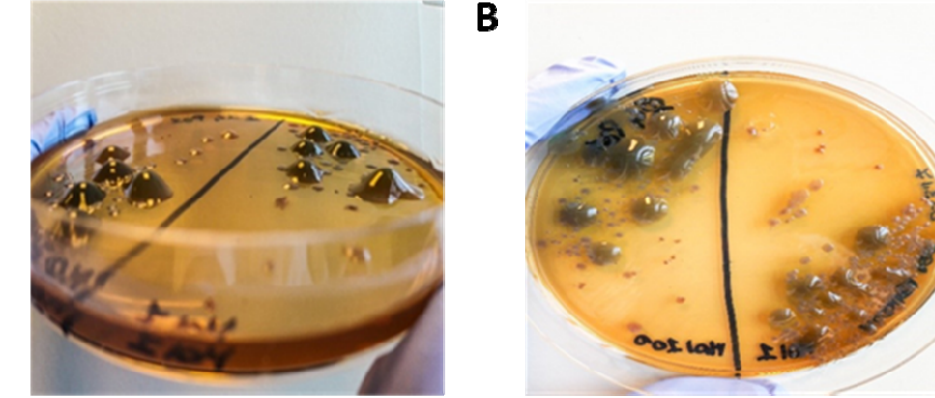
Figure 6. Mucoid Pseudomonas aeruginosa (PA) phenotypes observed in the biofilm supernatants exposed to phages. ( A , B ) Blob-like, raised mucoid colonies, after 48-h-incubation at 37 ◦ C, grown on MacConkey agar after exposing preformed PA biofilm to phages for 24